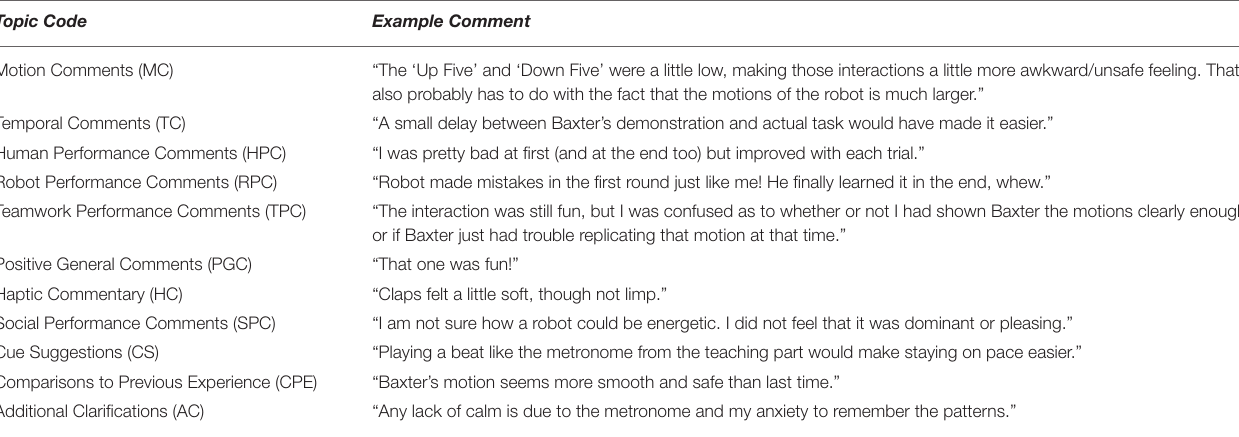
TABLE 3 | Example comments from each interaction block topic